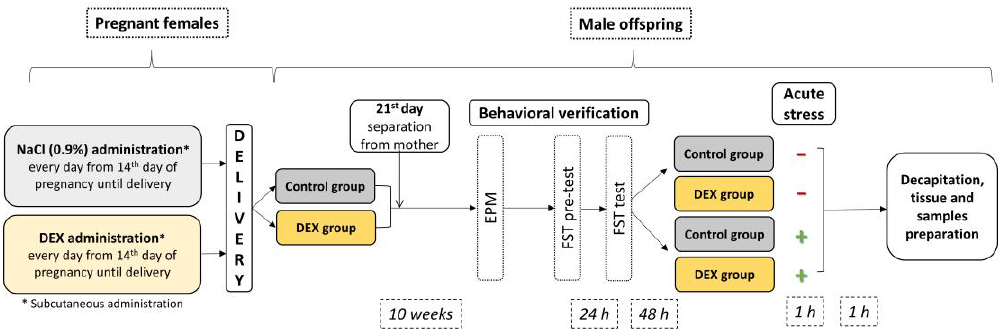
Figure 1. Schematic diagram of the experiment.